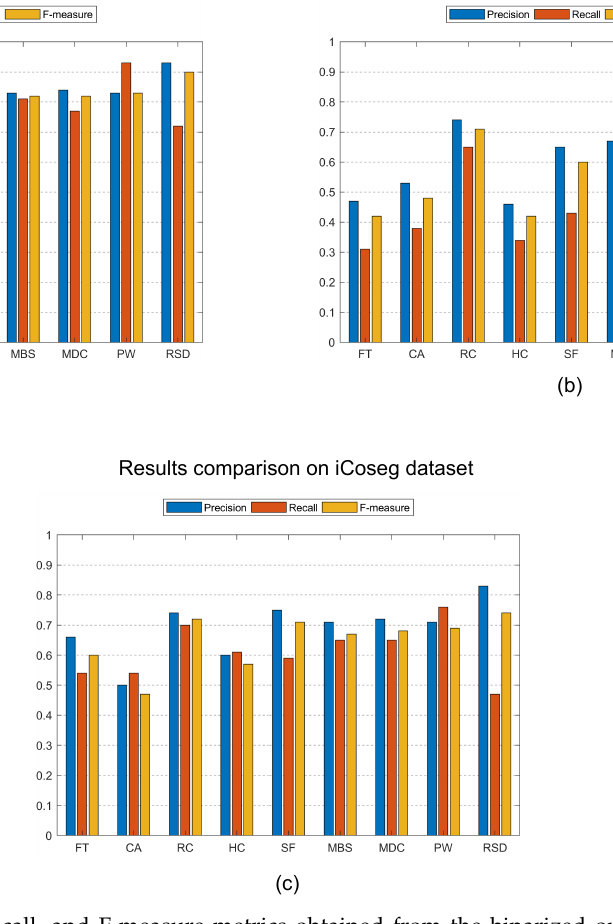
Figure 6. Precision, Recall, and F-measure metrics obtained from the binarized outcomes of the methods: ( a ) MSRA1K dataset; ( b ) ECSSD dataset; and ( c ) iCoseg dataset.